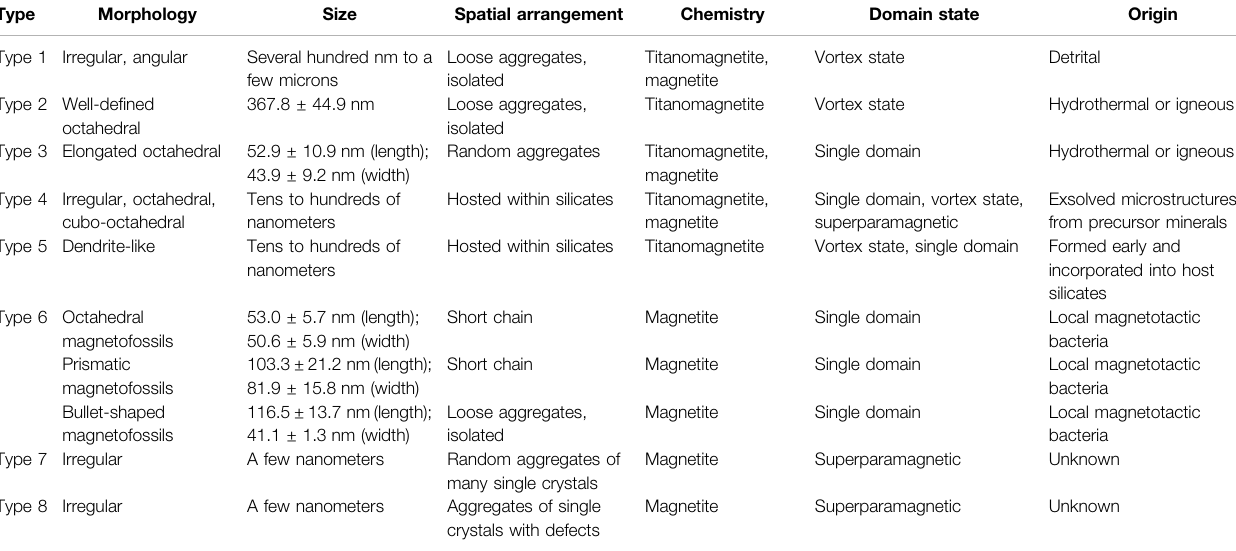
TABLE 1 | Magnetic mineral types identi fi ed in sample